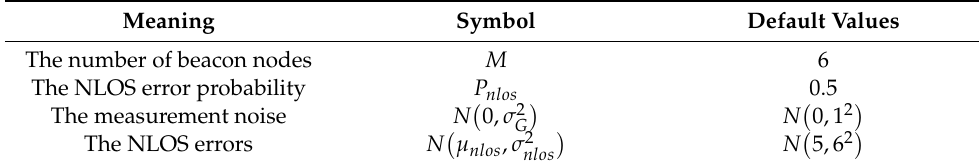
Table 1. Gaussian distribution